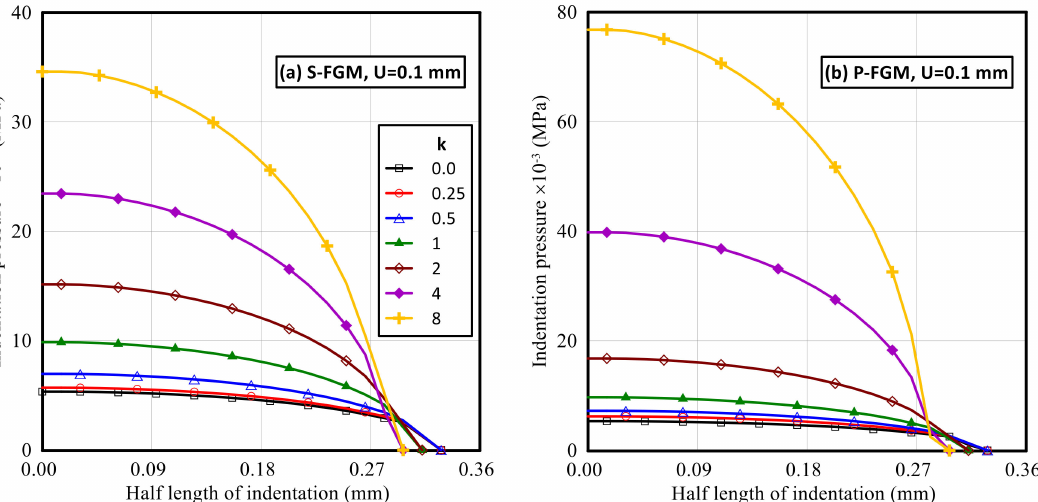
Figure 8. Distributions of the indentation pressure (at full load) along the half length of indentation for the elastoplastic Ti/TiB specimen at different gradient indices; ( a ) S-FGM, and ( b ) P-FGM. Distributions of the equivalent von Mises stress and the equivalent plastic strain at full load within the elastoplastic Ti/TiB specimen at different gradient indices for both S-FGM and P-FGM distributions are depicted in Figures 9 and 10, respectively. It is observed that increasing the material gradation index through the loading path results in increasing the equivalent von Mises stress and decreasing the equivalent plastic strain due to decreasing the material compliance for both S-FGM and P-FGM distributions. On the other hand, due to the increase in S-FGM compliance, smaller values of the equivalent von Mises stress and larger values of the equivalent plastic strain are produced compared with the corresponding cases of P-FGM for all values of the material gradation